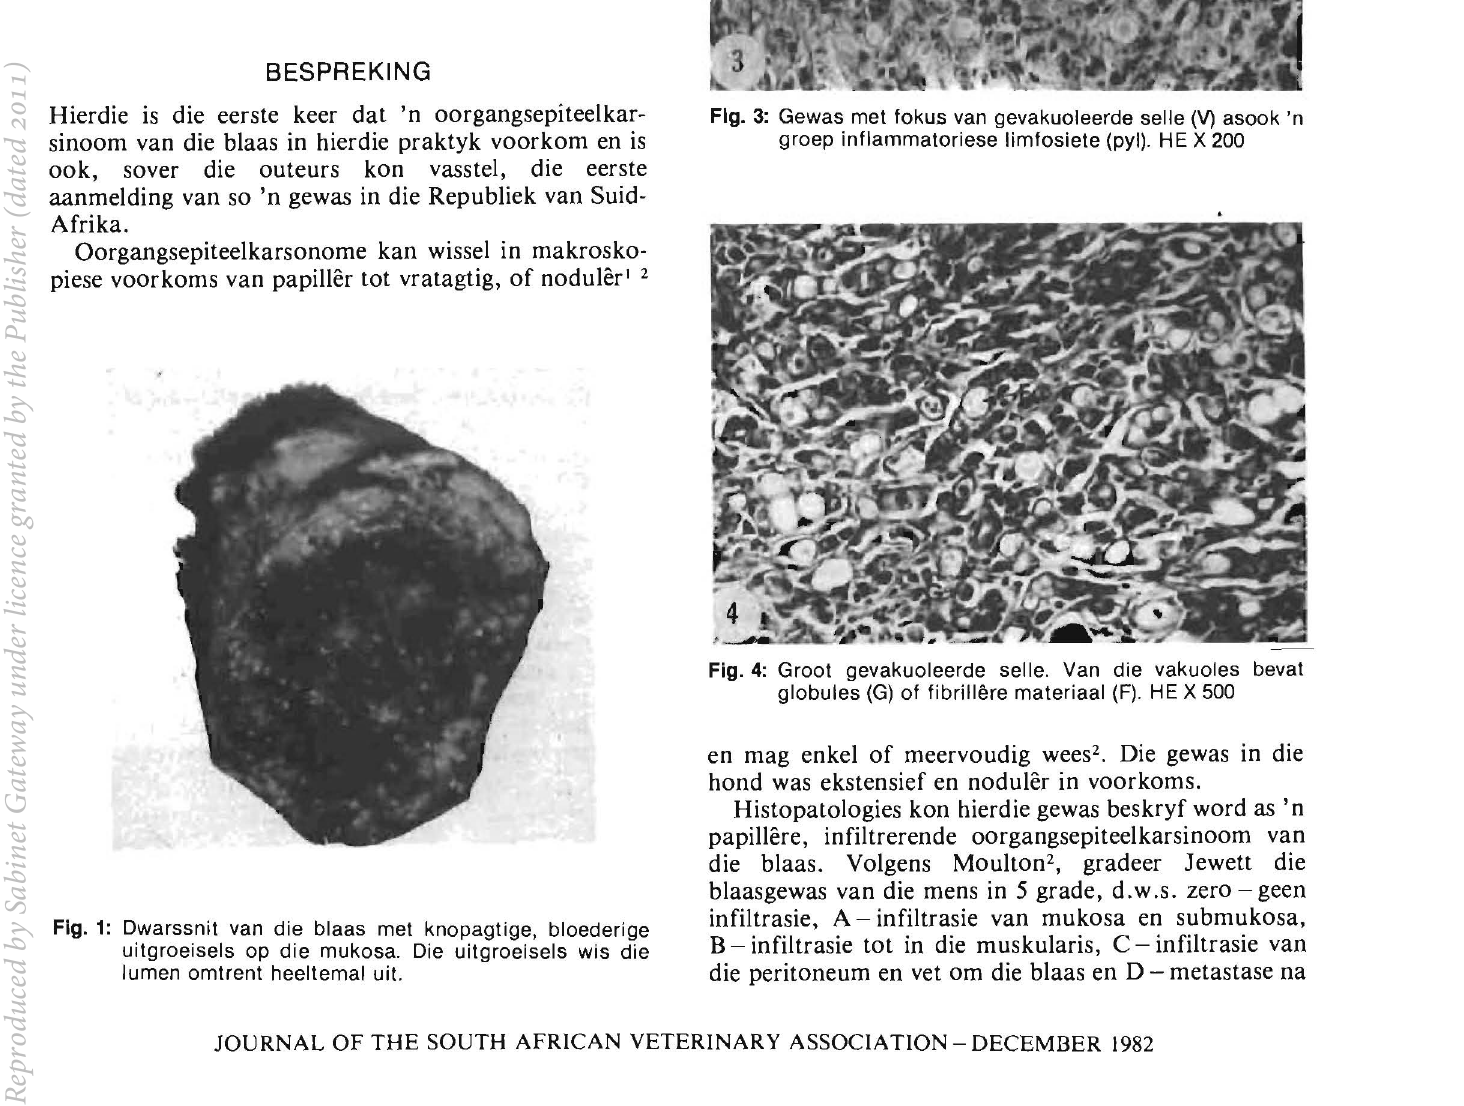
Fig. 1: Dwarssnit van die blaas met knopagtige, bloederige uitgroeisels op die mukosa. Die uitgroeisels wis die lumen omtrent heeltemal uit.